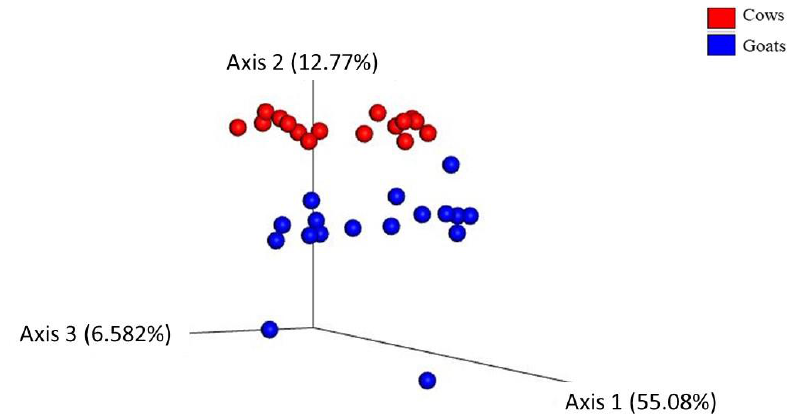
Figure 2. Principal Coordinate Analysis (PCoA) showing the weighted UniFrac distance matrix of bacterial 16S rRNA amplicons from fecal samples of cow (red color) and goat (blue color) groups. Each dot represents one sample. The percentage of variation explained by the plotted principal coordinates is indicated on the axes. Table 1. Permutational multivariate analysis of variance (PERMANOVA) and dispersions (PERMDISP) showing significant differences in beta diversity between cows and goats ( p < 0.05).